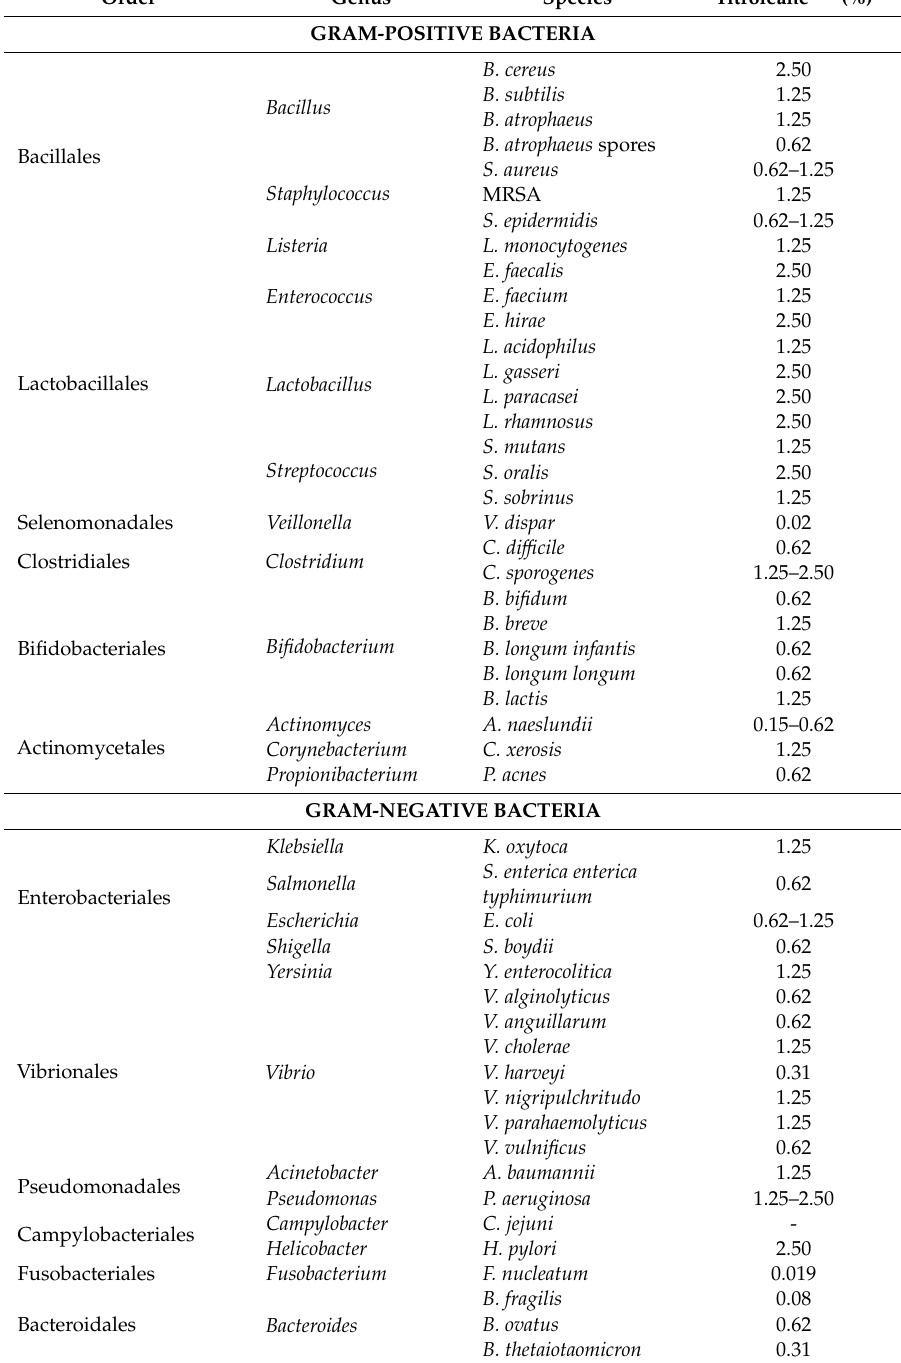
Table 4. Antimicrobial spectrum of Titroleane ™ on bacteria and fungi encountered in human and animal